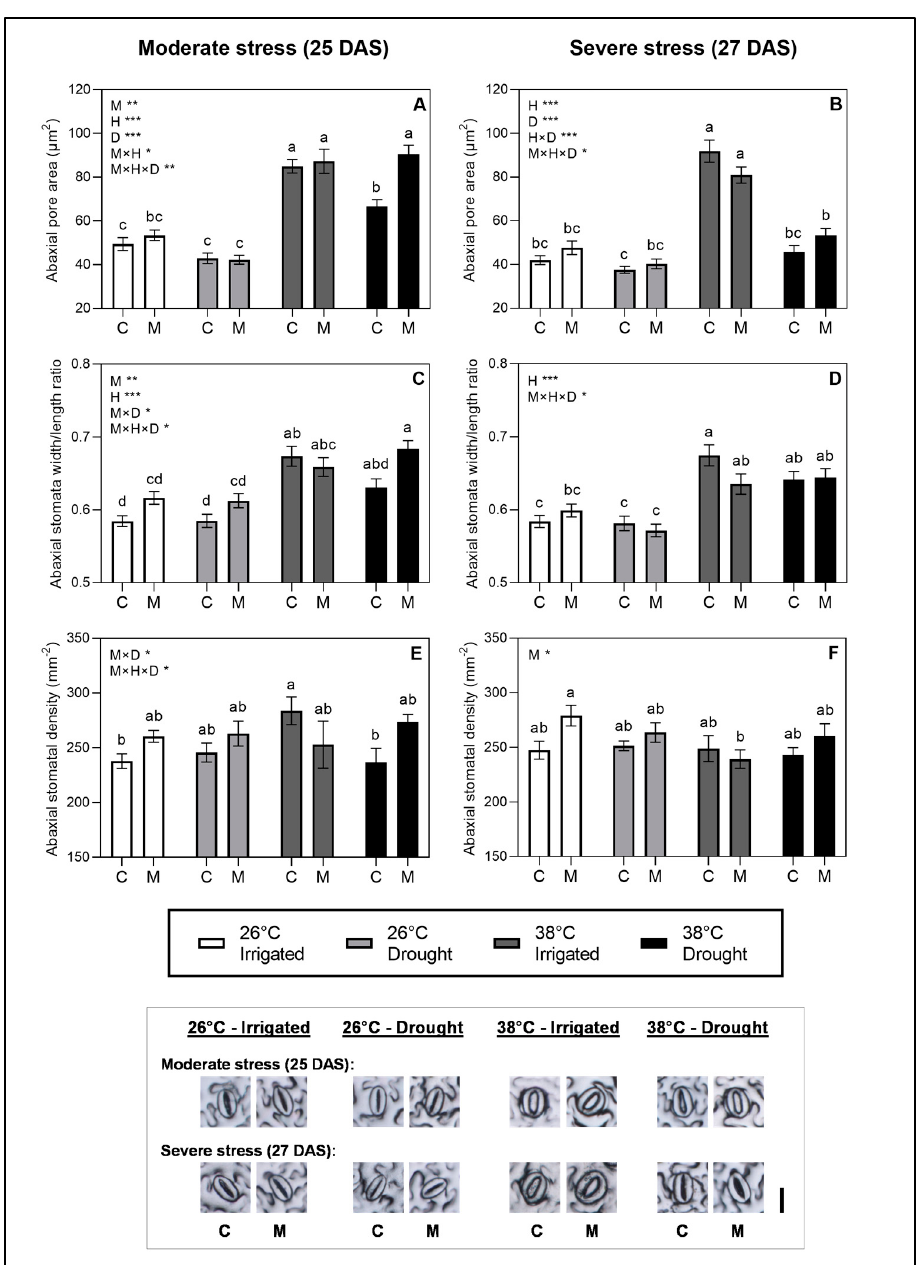
Figure 2. Stomatal anatomy from the abaxial leaf side on plants during moderate stress (drought- stressed at SRWC ~50% and heat stress for 1 day) and severe stress (drought-stressed at SRWC ~20% and heat stress for 3 days). Stomatal anatomy included abaxial pore area ( A , B ), abaxial stomata width/length ratio ( C , D ) and abaxial stomatal density ( E , F ) during moderate and severe stress. Values are mean ± SE. The effects of the three factors studied—heat stress (H), drought stress (D), melatonin treatment (M)—and their interaction are indicated in the left, upper corners of graphs. Significance levels are indicated by ***, p < 0.001; **, p < 0.01; *, p < 0.05, whereas factors with no significant effect ( p > 0.05) are not listed. Lower-case letters on bars indicate differences between groups within each stress level significant at p < 0.05 in the post hoc multiple comparisons. Representative images of stomata from each treatment at each stress level are shown in subfigure below graphs. Scale bar (lower right corner), 25 µ